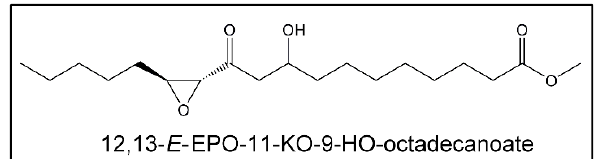
Figure 10. Chemical structure of epoxy-keto-hydroxy derivatives (EPO-KO-HOs), 12,13-EPO- E -11- KO-9-HO-octadecanoate.